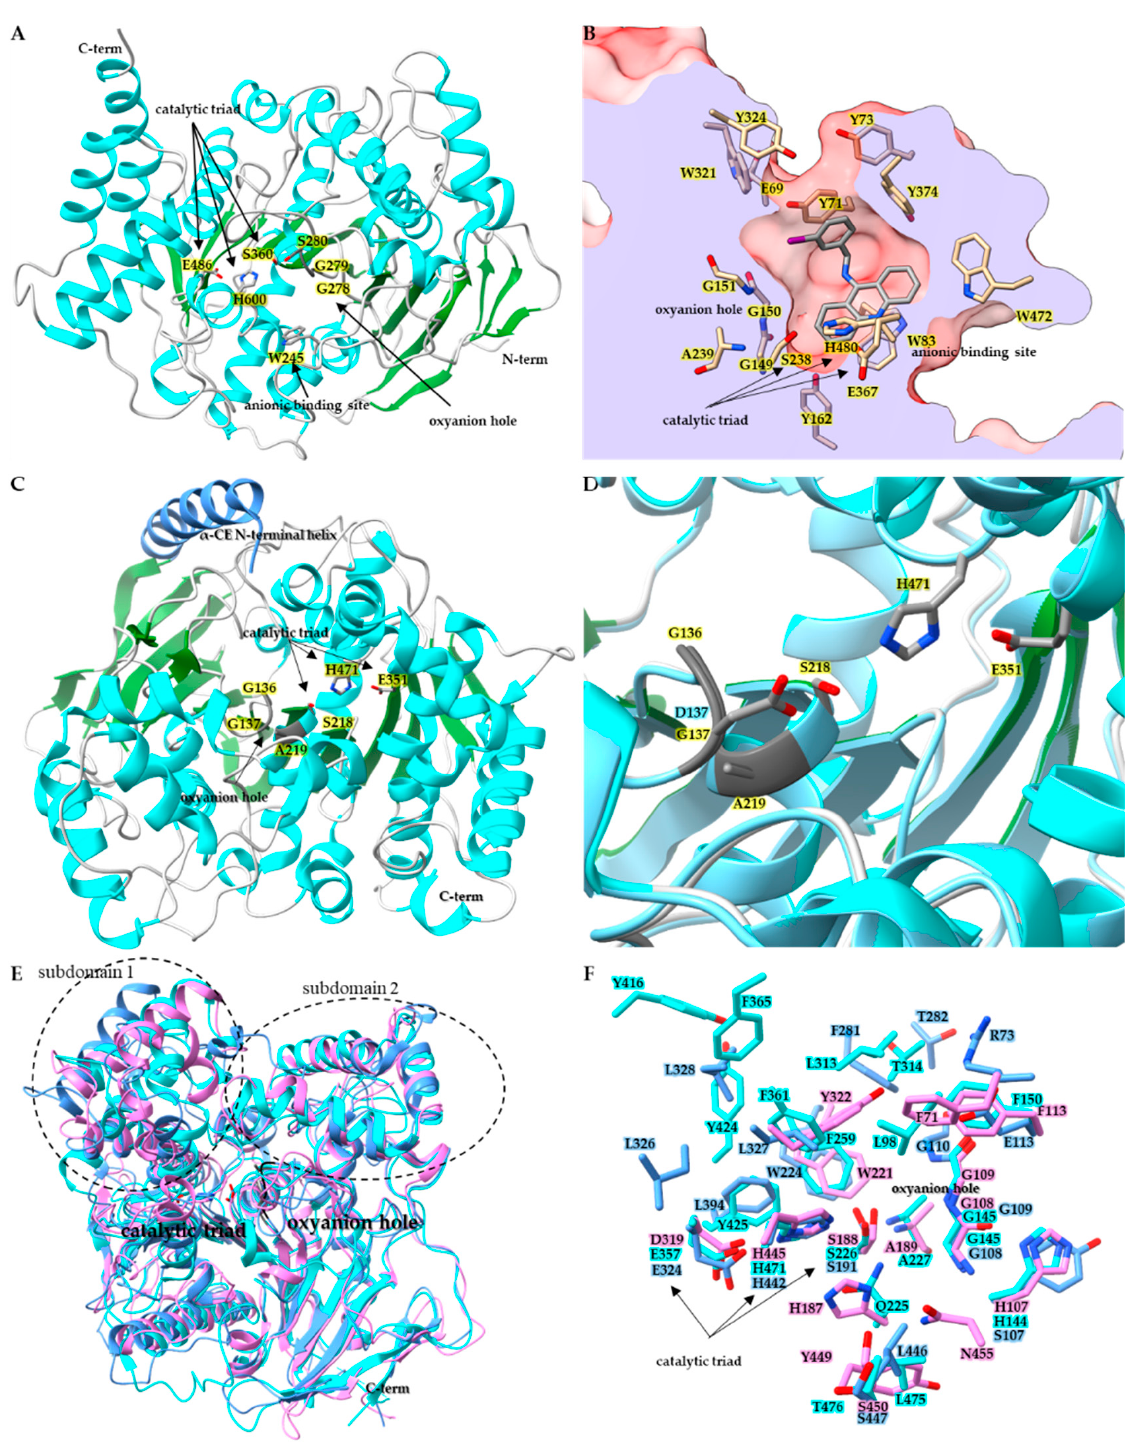
Figure 1. Structures of insect CCEs. ( A ) Ribbon diagram of acetylcholinesterase (PDB: 6ARX) from Anopheles gambiae . Side chains for key active site residues are shown and colored by element: catalytic triad Ser360, Glu486, His600, and oxyanion hole residues Gly278, Gly279, Gly280Ser mutation,